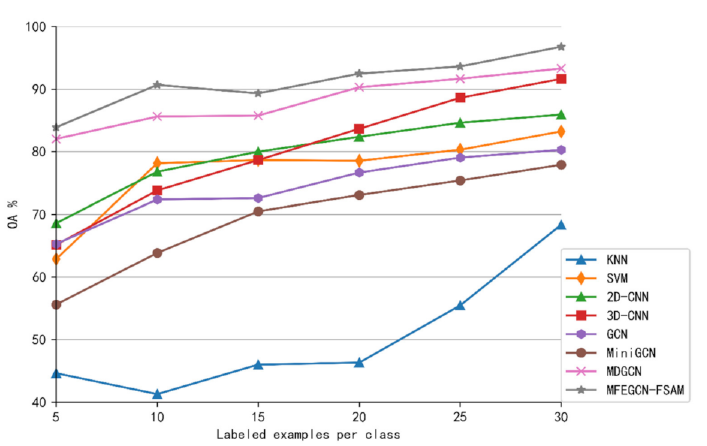
Figure 16. Overall accuracies of different methods on the Indian Pines dataset under different numbers of labeled examples per class.